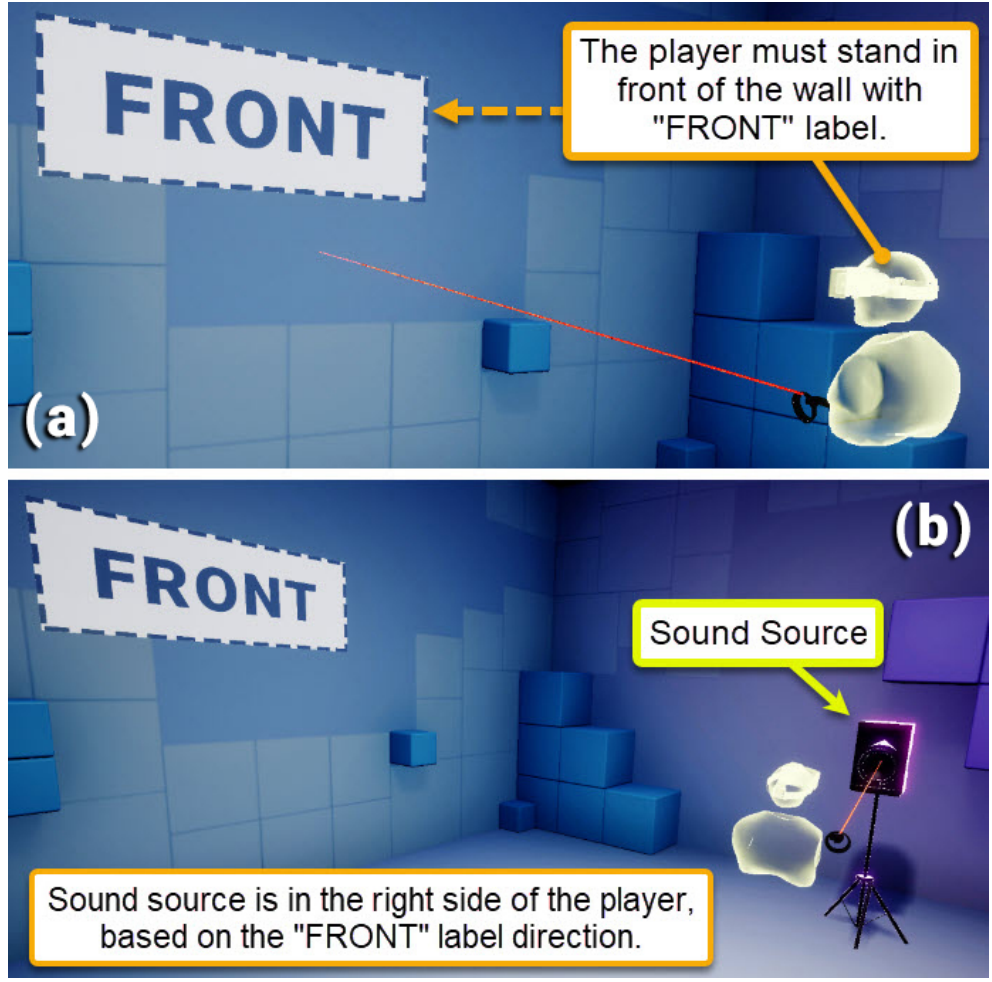
Figure 3. The VR environment, ( a ) The “FRONT” label position, ( b ) Sound source position based on the “FRONT” label direction.